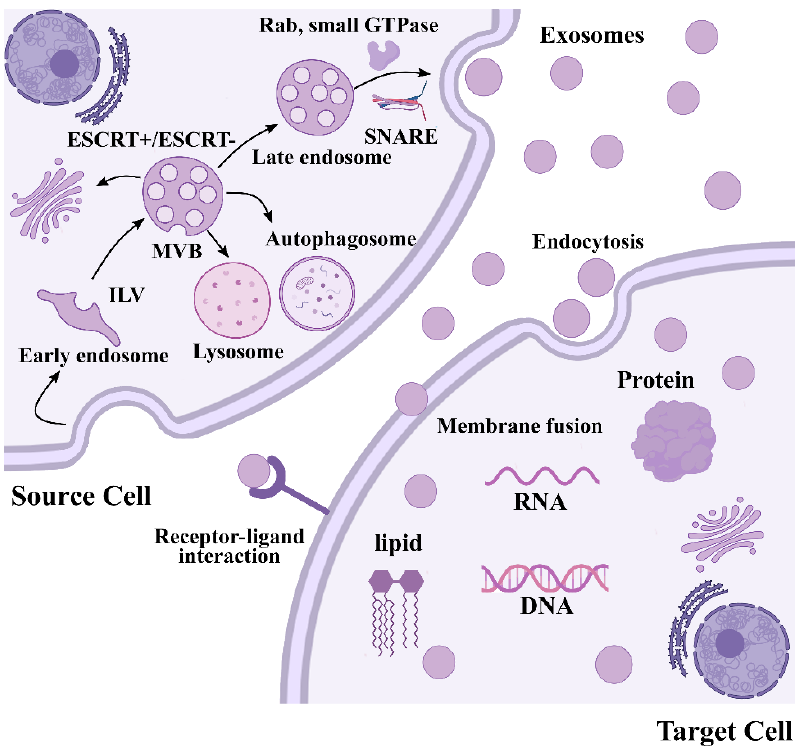
Figure 1. Schematic representation of biogenesis of exosomes. Exosome biogenesis starts with the invagination of the endocytic membrane and formation of ILVs inside the cell. During maturation, the cargoes (RNAs, proteins, and lipids) are incorporated into ILV through ESCRT-dependent or ESCRT-independent pathways. Then, MVBs containing exosomes are formed, followed by recycling, degradation, or releasing exosomes into the extracellular space. Finally, exosomal cargoes from exosomes are transported from the donor cell to the receiving one via endocytosis, direct membrane fusion, or receptor-ligand